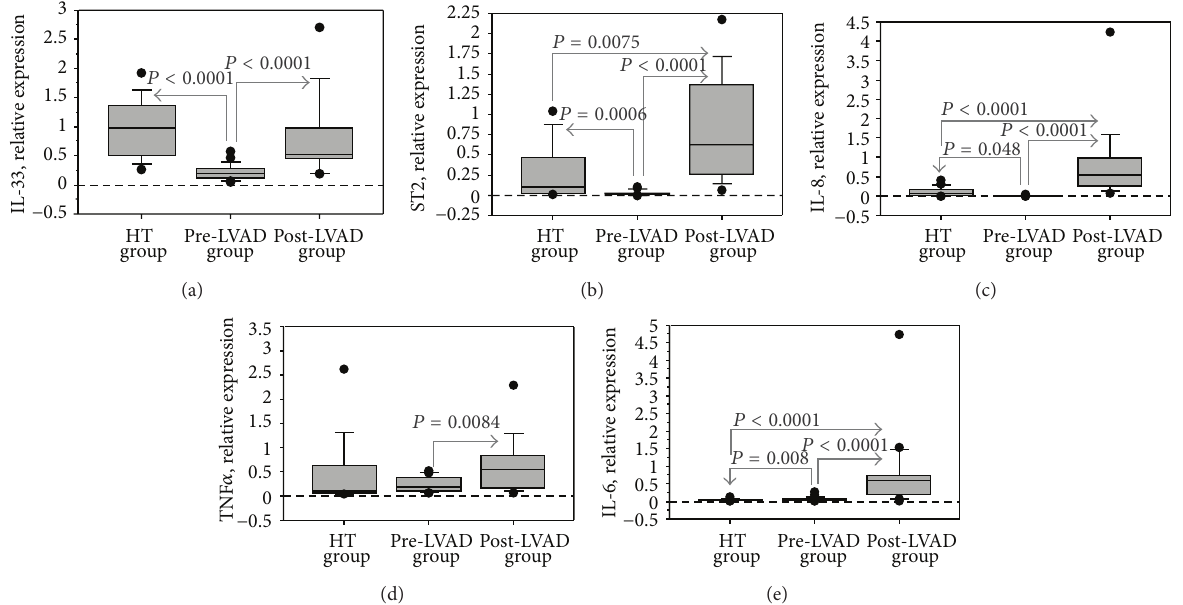
Figure1:RegulationofmediatorsofinflammationincardiactissuefromESHFpatientofpre-LVADgroup,HTcontrolgroup,andpost-LVAD group. Relative quantification of IL-33 (a), ST2 (b), IL-8 (c), TNF- 𝛼 (d), and IL-6 (e) is shown.